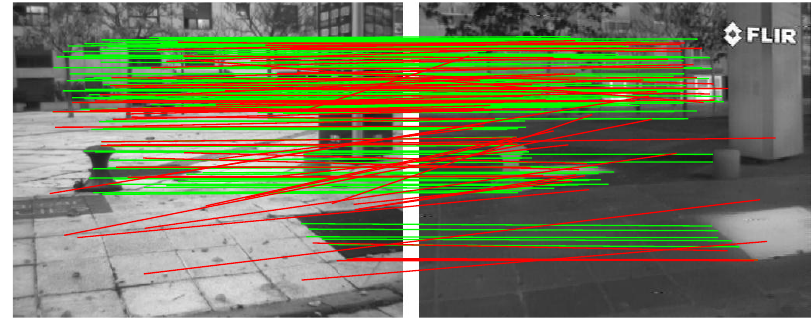
Figure 15. The correctly matched (green lines) and falsely matched (red lines) results for SURF ( a ), LGHD ( b ), and our HOMPC ( c ) descriptors. The displayed green and red lines are used to visually compare the descriptor performance. The greater number of the green lines, the better. The higher the ratio of the green lines, the better. The quantitative results are also listed below each pair of images.